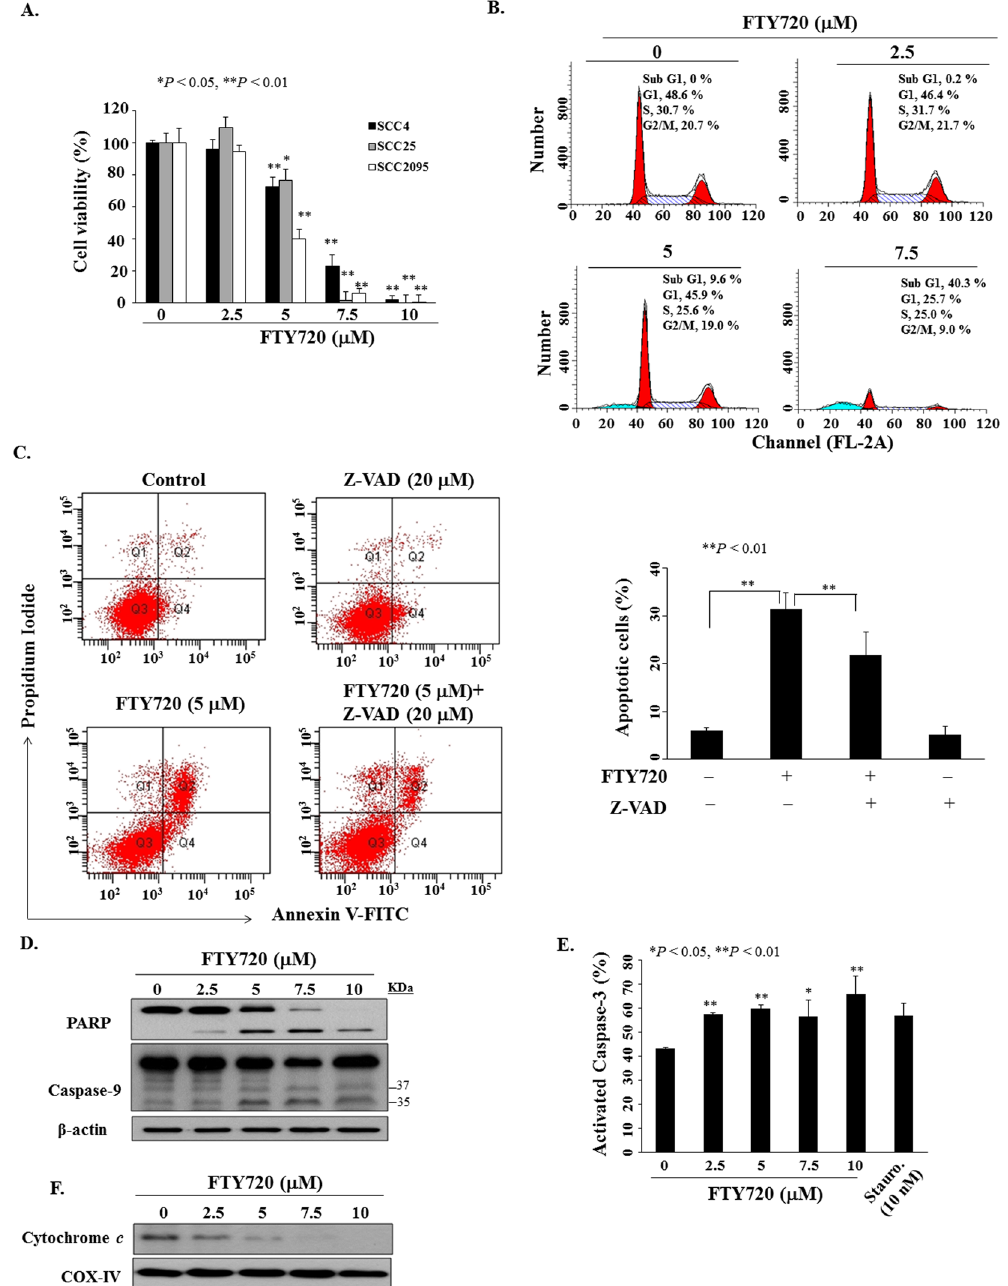
Figure 1. FTY720 induced cell death. ( A ) Effect of FTY720 at the indicated concentrations on the viability of oral cancer cells. Cells were treated with FTY720 in 5% FBS-supplemented DMEM/F12 medium in 96- well plates at 24 h, and cell viability was assessed by MTT assays. Points , means; bars , S.D. (n = 6). * P < 0.05, ** P < 0.01 compared to the control group. ( B ) Cell cycle analysis showed an increased sub-G1 phase population in SCC2095 cells treated with FTY720 for 24 h. ( C ) Left, flow cytometric analysis of apoptotic death in SCC2095 cells after the treatment of FTY720 (5 μ M) for 24 h with or without pretreatment of Z-VAD(OMe)-FMK (Z- VAD, 20 μ M) for 1 h. Right, percentages in the graphs represent the percent of cells in the respective quadrants. Columns , means; bar , S.D. (n = 3). ** P < 0.01. ( D ) Dose-dependent effect of FTY720 on caspase-9 activation and PARP cleavage in SCC2095 cells after 24 h exposure in 5% FBS-supplemented DMEM/F12 medium. ( E ) FTY720 induced a dose-dependent increase of activated caspase-3. * P < 0.05, ** P < 0.01 when compared with the control group. Cells exposed to staurosporine (Stauro.) at 10 nM were used as a positive control. ( F ) Western blotting of mitochondrial